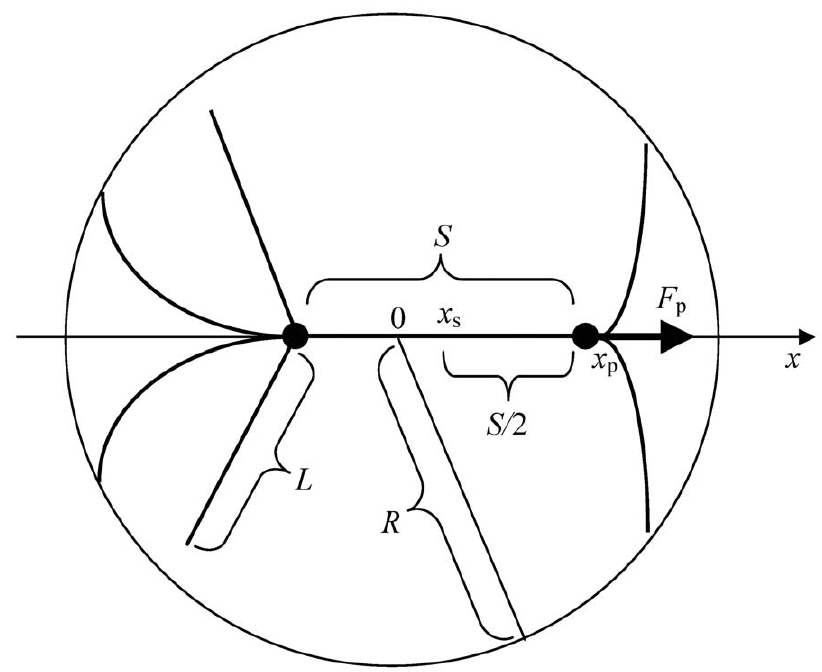
Figure 1. Model and notation.